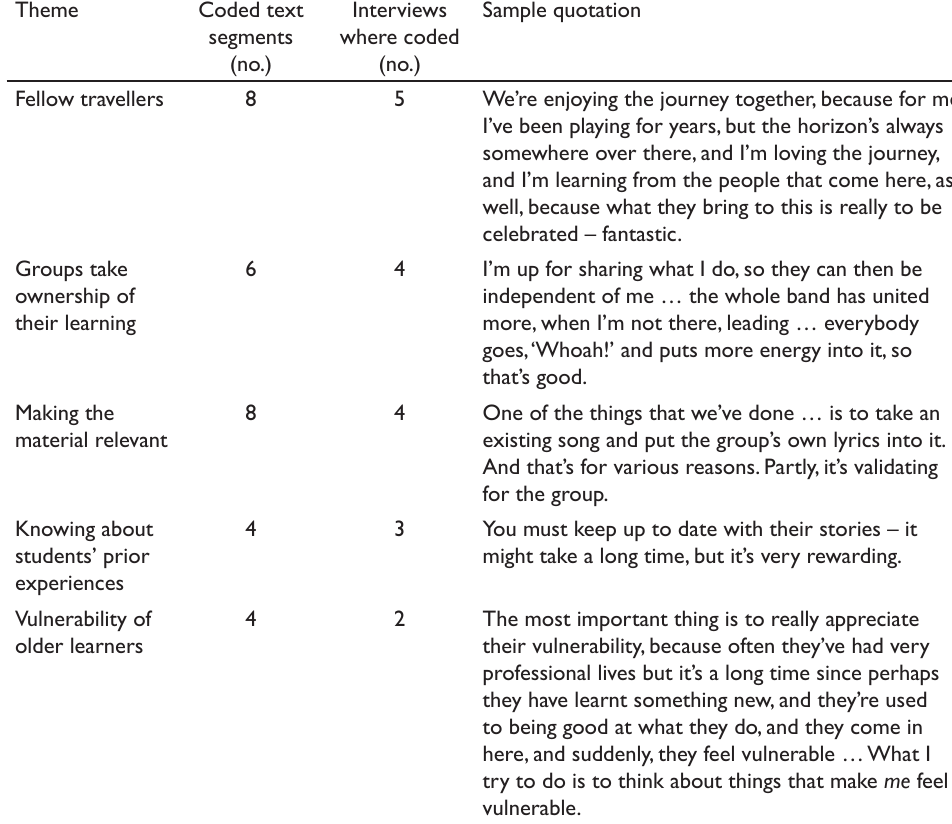
Table 1: Supporting person-centred